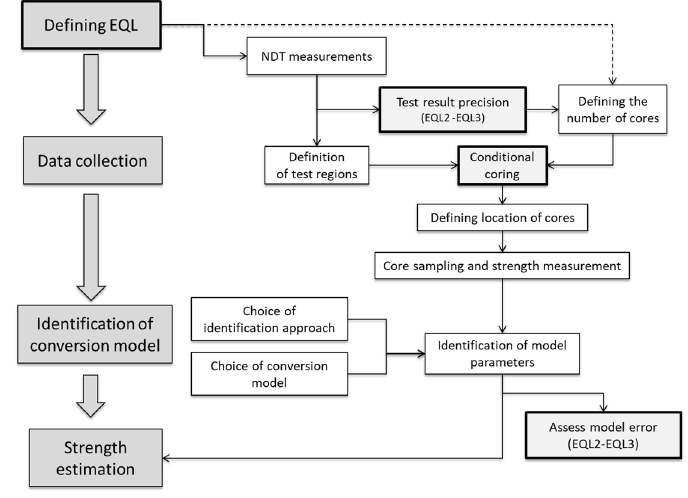
Figure 3. Detailed steps of the recommended concrete strength assessment process.